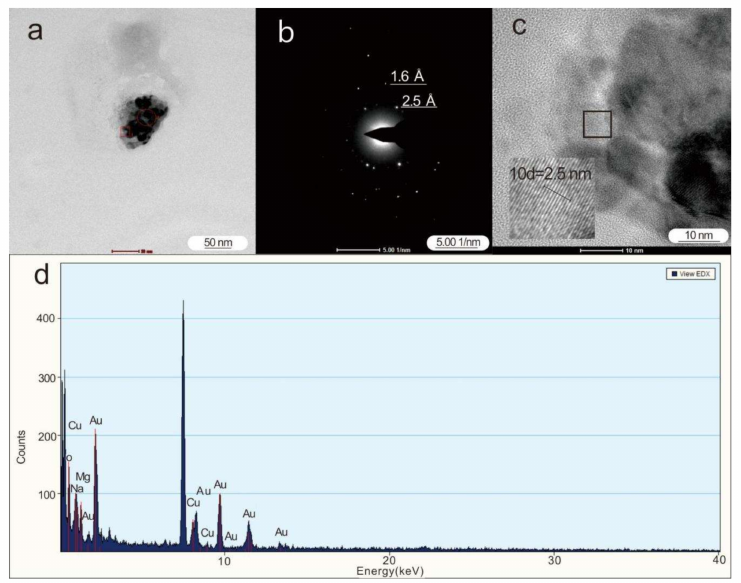
Figure 4. ( a ) TEM photomicrographs, ( b ) SAED pattern, ( c ) HRTEM image and ( d ) EDS spectrum of Au-, Cu-bearing nanoparticle carried by the deep-seated fault gouge (ID1).